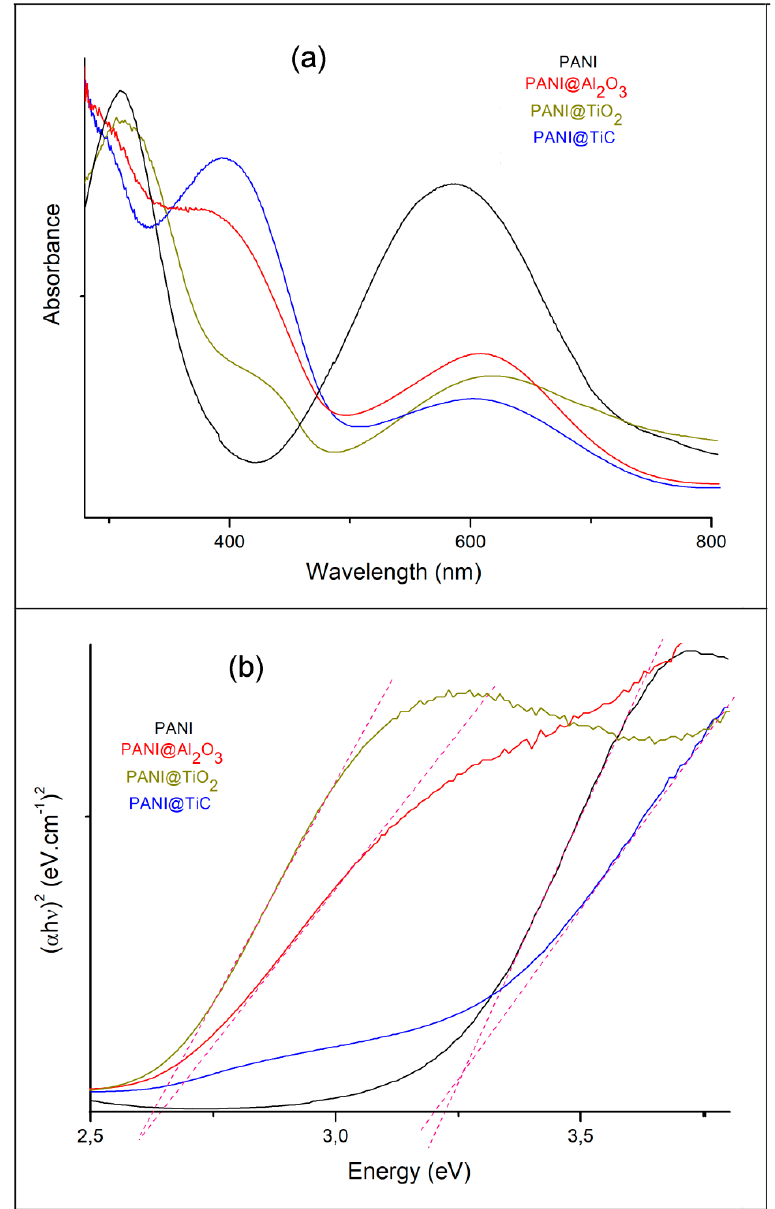
Figure 5. UV/visible (UV/Vis) spectroscopy absorption spectra ( a ) and Tauc plots ( b ) of synthesized samples.